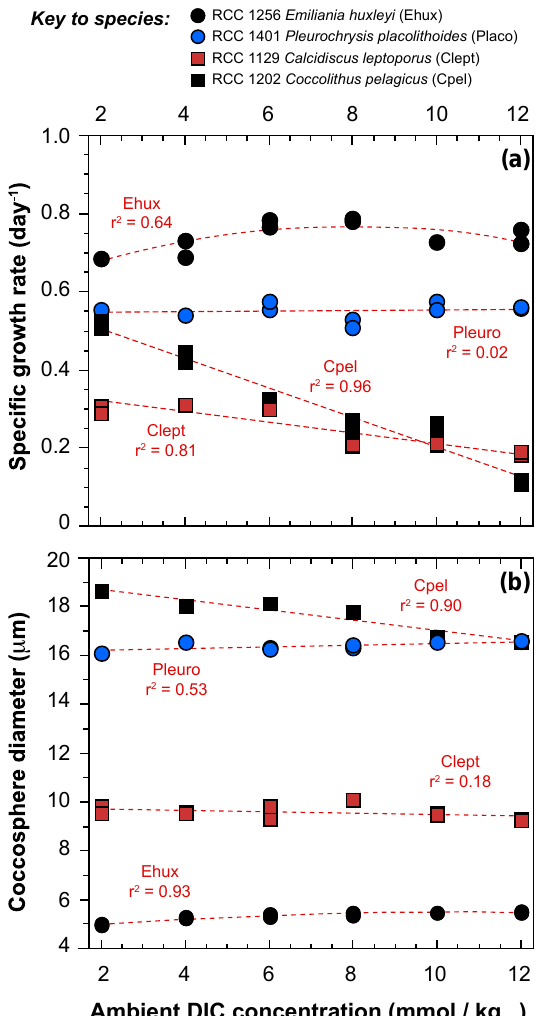
Figure 1. Changes in algae specific growth rates (a) and cocco- sphere diameter (b) on a range of 2 to 12mmolkg − 1 of DIC per kg of seawater in the culture medium. Key for species is inset at the top of the